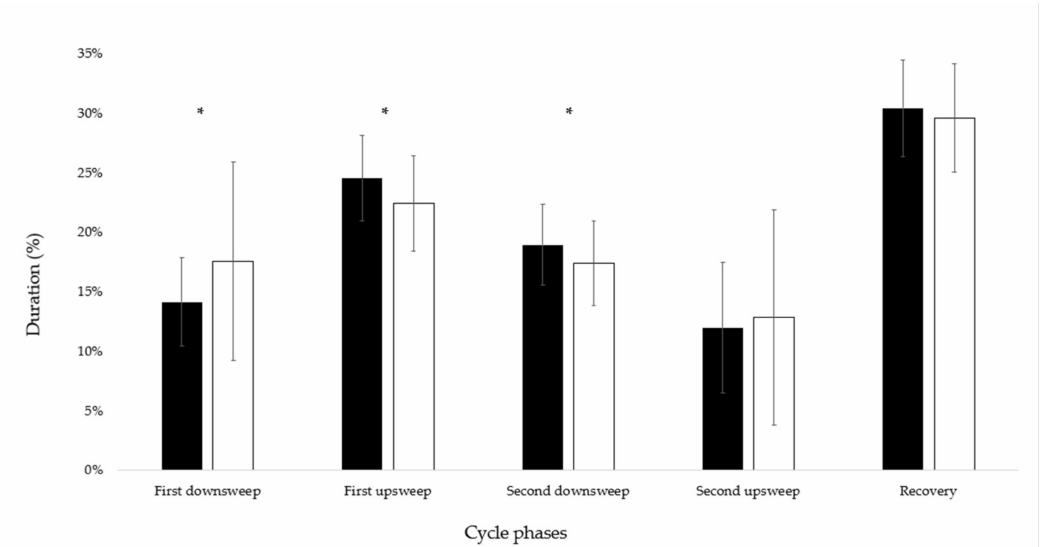
Figure 4. Relative duration of elite and good-level swimmers’ backstroke cycle phases (black and white colors, respectively). * Represents differences between groups.